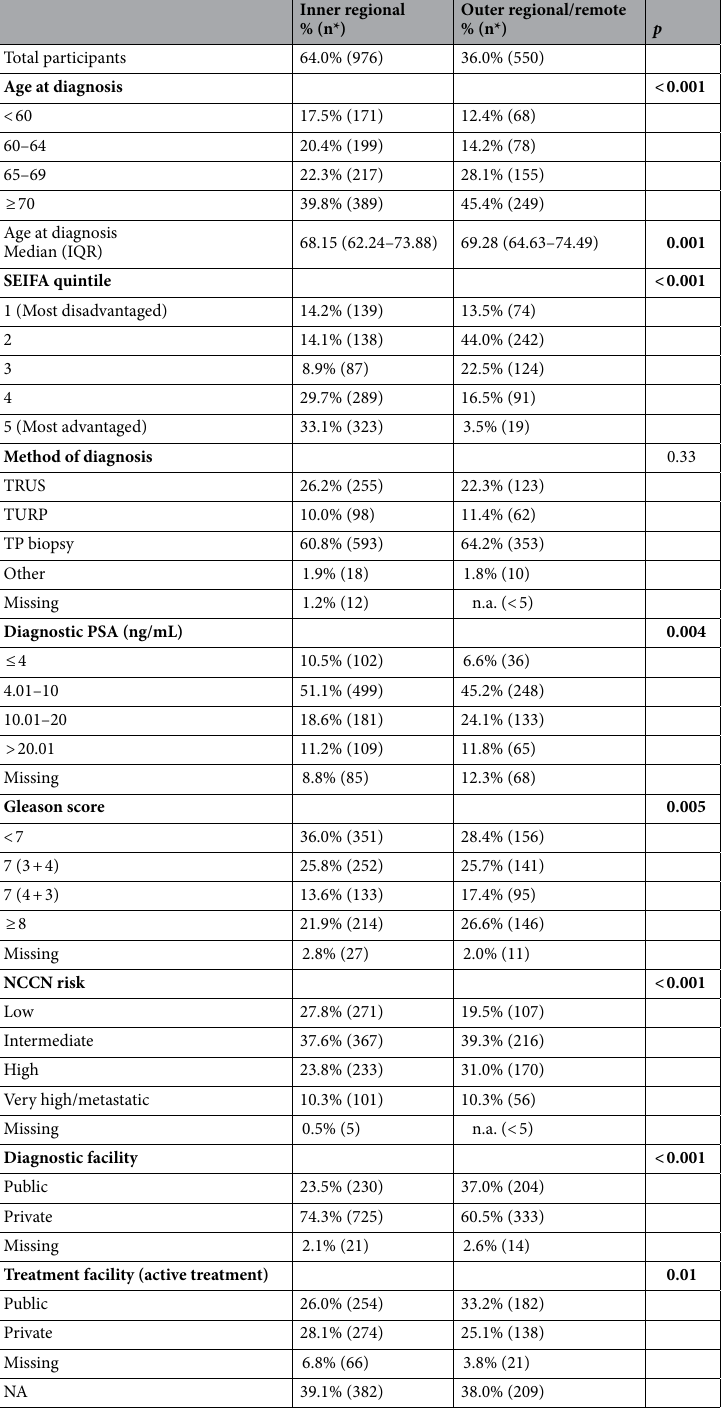
Table 1. Demographic and clinical characteristics of men with prostate cancer in inner and outer regional/ remote areas of Tasmania. IQR = Interquartile Range; SEIFA = Socio-Economic Index of Advantage and Disadvantage; TRUS = Transrectal Ultrasound; TURP = Transurethral Resection of the Prostate; TP Biopsy = Transperineal Biopsy; PSA = Prostate Specific Antigen; NCCN = National Comprehensive Cancer Network; n.a. = Not Applicable. *All analyses are weighted for remoteness classification (see “Methods”). Subject numbers are rounded to the nearest integer